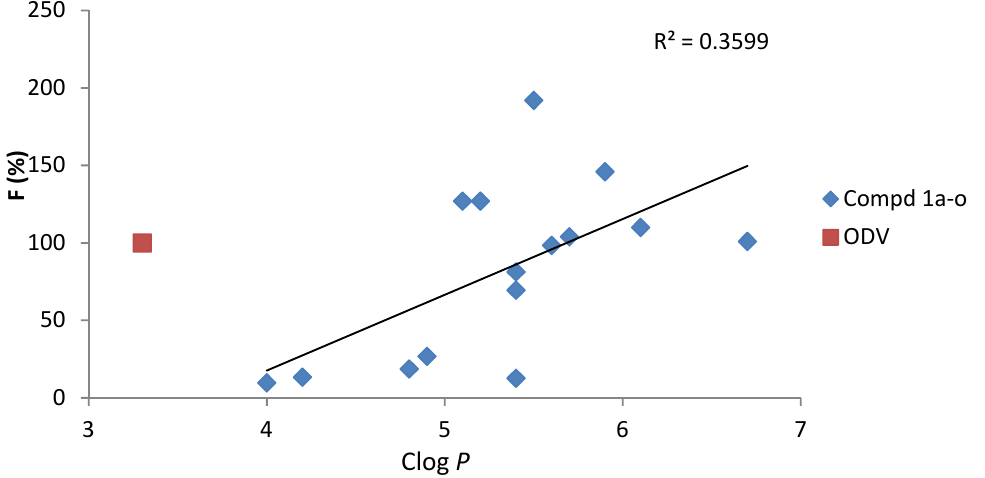
linear regression line of best